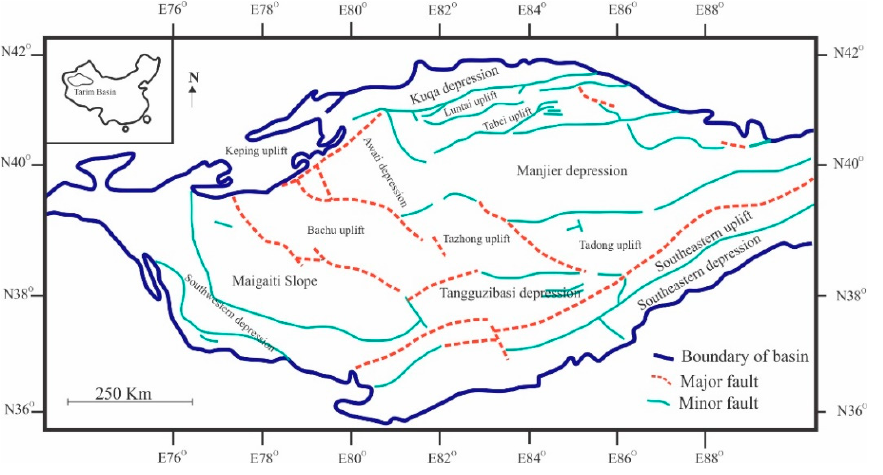
Figure 1. Tarim Basin limit and faults map.